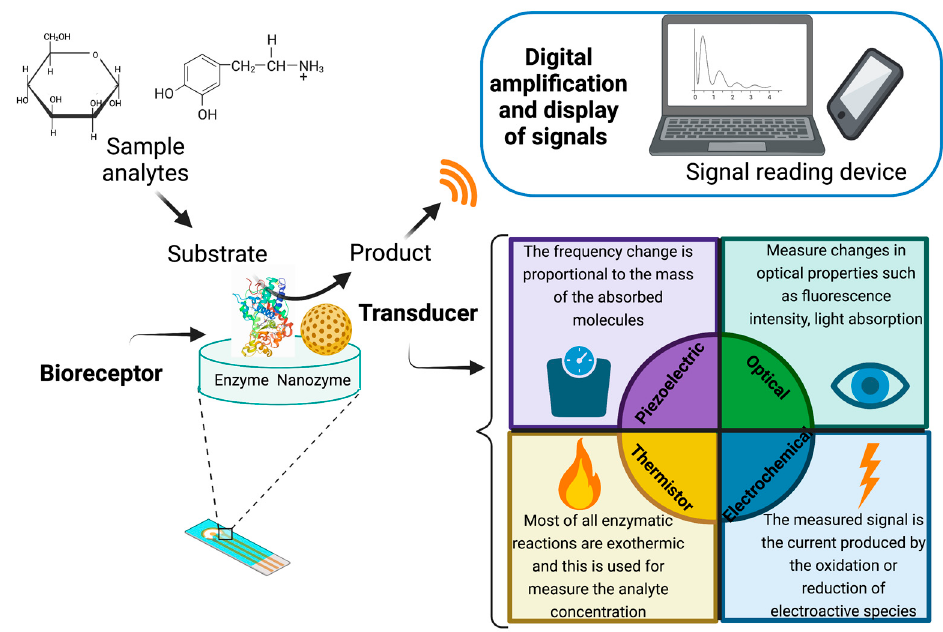
Figure 1. Main biosensing elements and their mechanistic